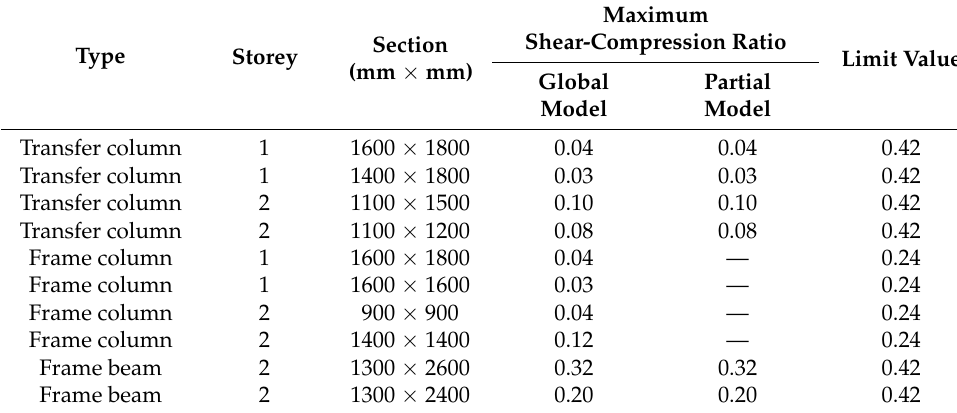
Table 12. Shear-compression ratios of typical structural